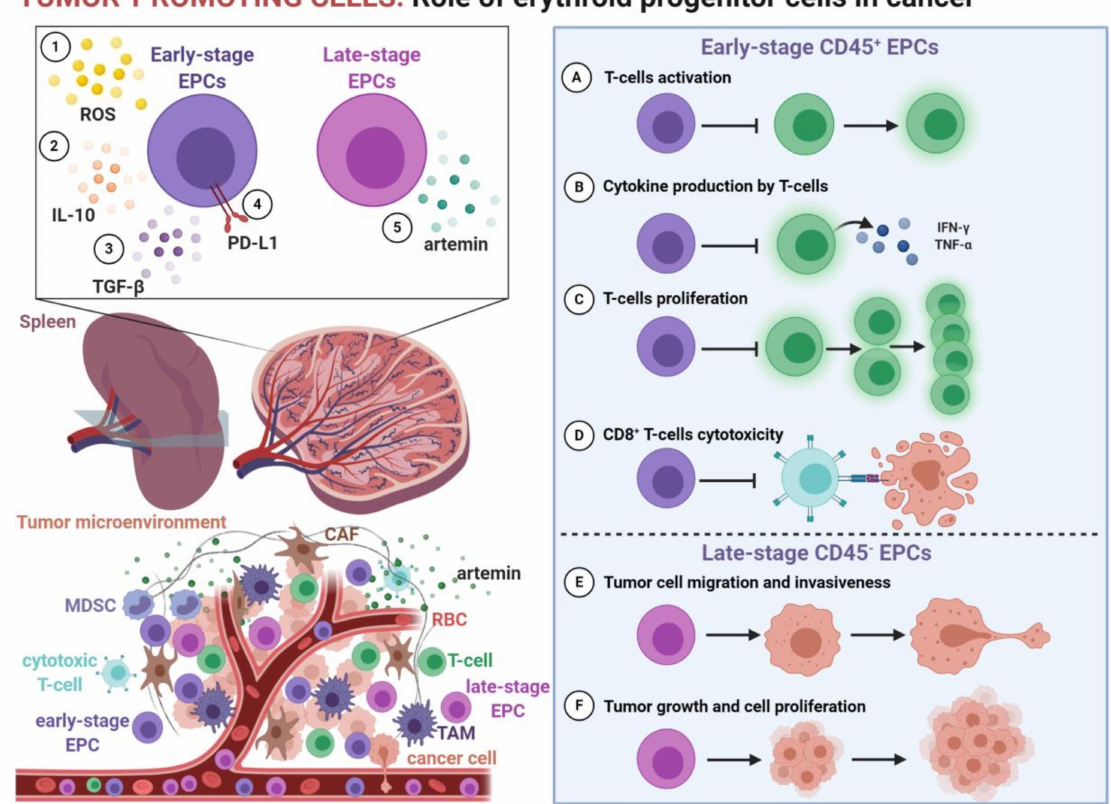
Figure 1. The role of erythroid progenitor cells (EPCs) in cancer. During disease progression, EPCs expand in the extramedullary sites, including the spleen. Moreover, EPCs are abundant in the peripheral blood of cancer patients and infiltrate the tumor microenvironment. Early-stage CD45 + EPCs use ( 1 ) reactive oxygen species (ROS), ( 2 ) interleukin-10 (IL-10), ( 3 ) transforming growth factor β (TGF- β ), and ( 4 ) programmed death-ligand 1 (PD-L1) to modulate the immune response. EPCs inhibit ( A ) T-cell activation, ( B ) production of interferon γ (IFN- γ ) and tumor necrosis factor α (TNF- α ), ( C ) T-cell proliferation, and ( D ) cytotoxicity of CD8 + T-cells. More mature CD45 − EPCs regulate cancer progression by ( 5 ) secretion of a neurotropic factor, artemin. These late-stage EPCs, called Ter-cells, promote ( E ) tumor cell migration and invasiveness as well as ( F ) tumor growth and cell